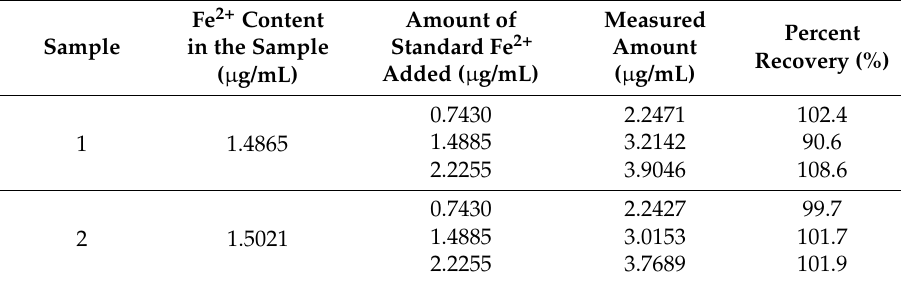
Table 2. The recovery rate of the determination of Fe 2+ in Tieguanyin